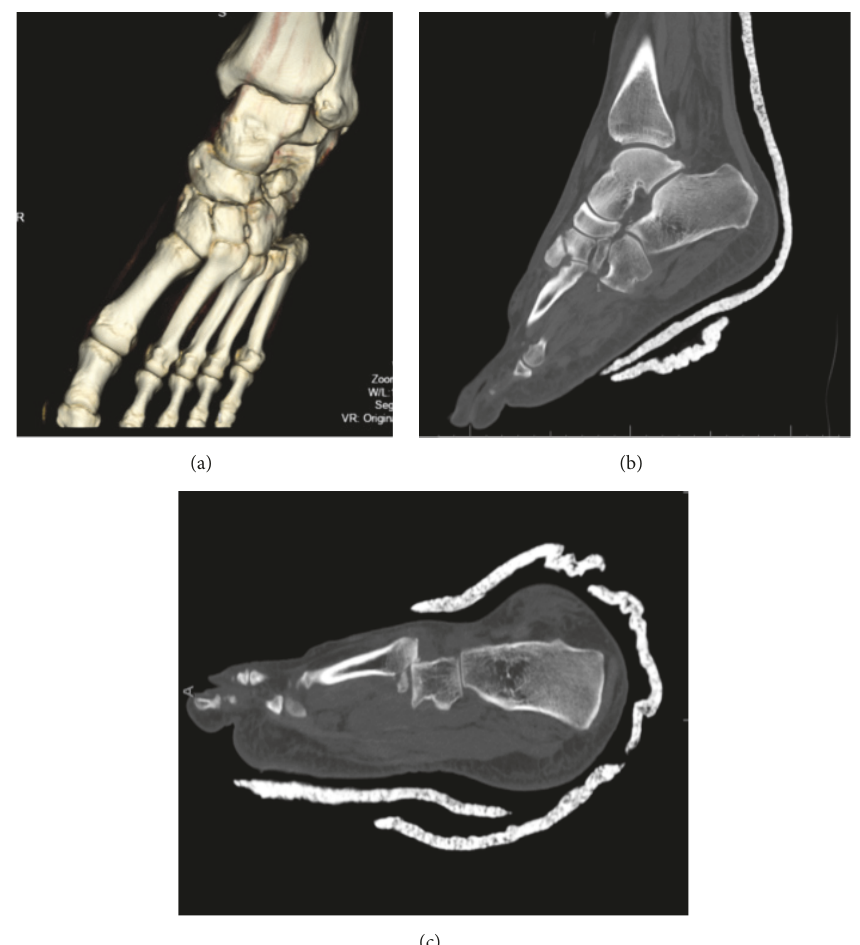
Figure 3: CT scan demonstrating dislocation of fourth and fifth tarsometatarsal joints.